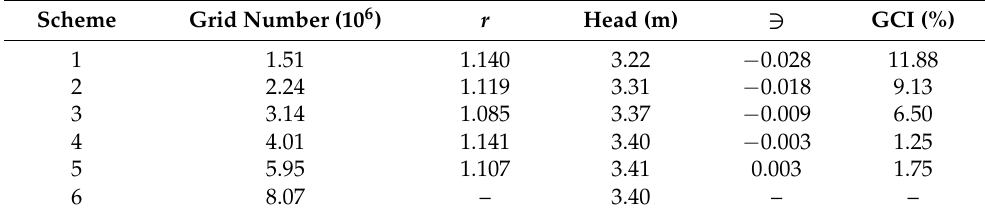
Table 2. The calculation of GCI.